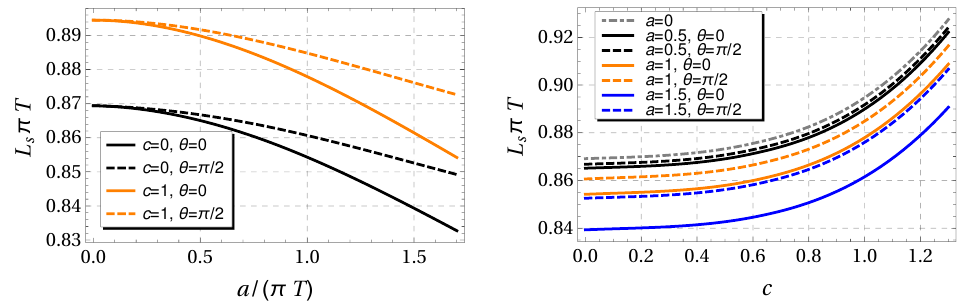
Figure 8 . Evolution of the screening distance for growing parameter a (left) and c (right) for di(cid:11)erent values of the respective other deformation parameter, parallel and perpendicular to the anisotropic direction. L s is always decreasing in a and increasing in c , so that the screening distance always behaves in both parameters as in the corresponding one-parameter